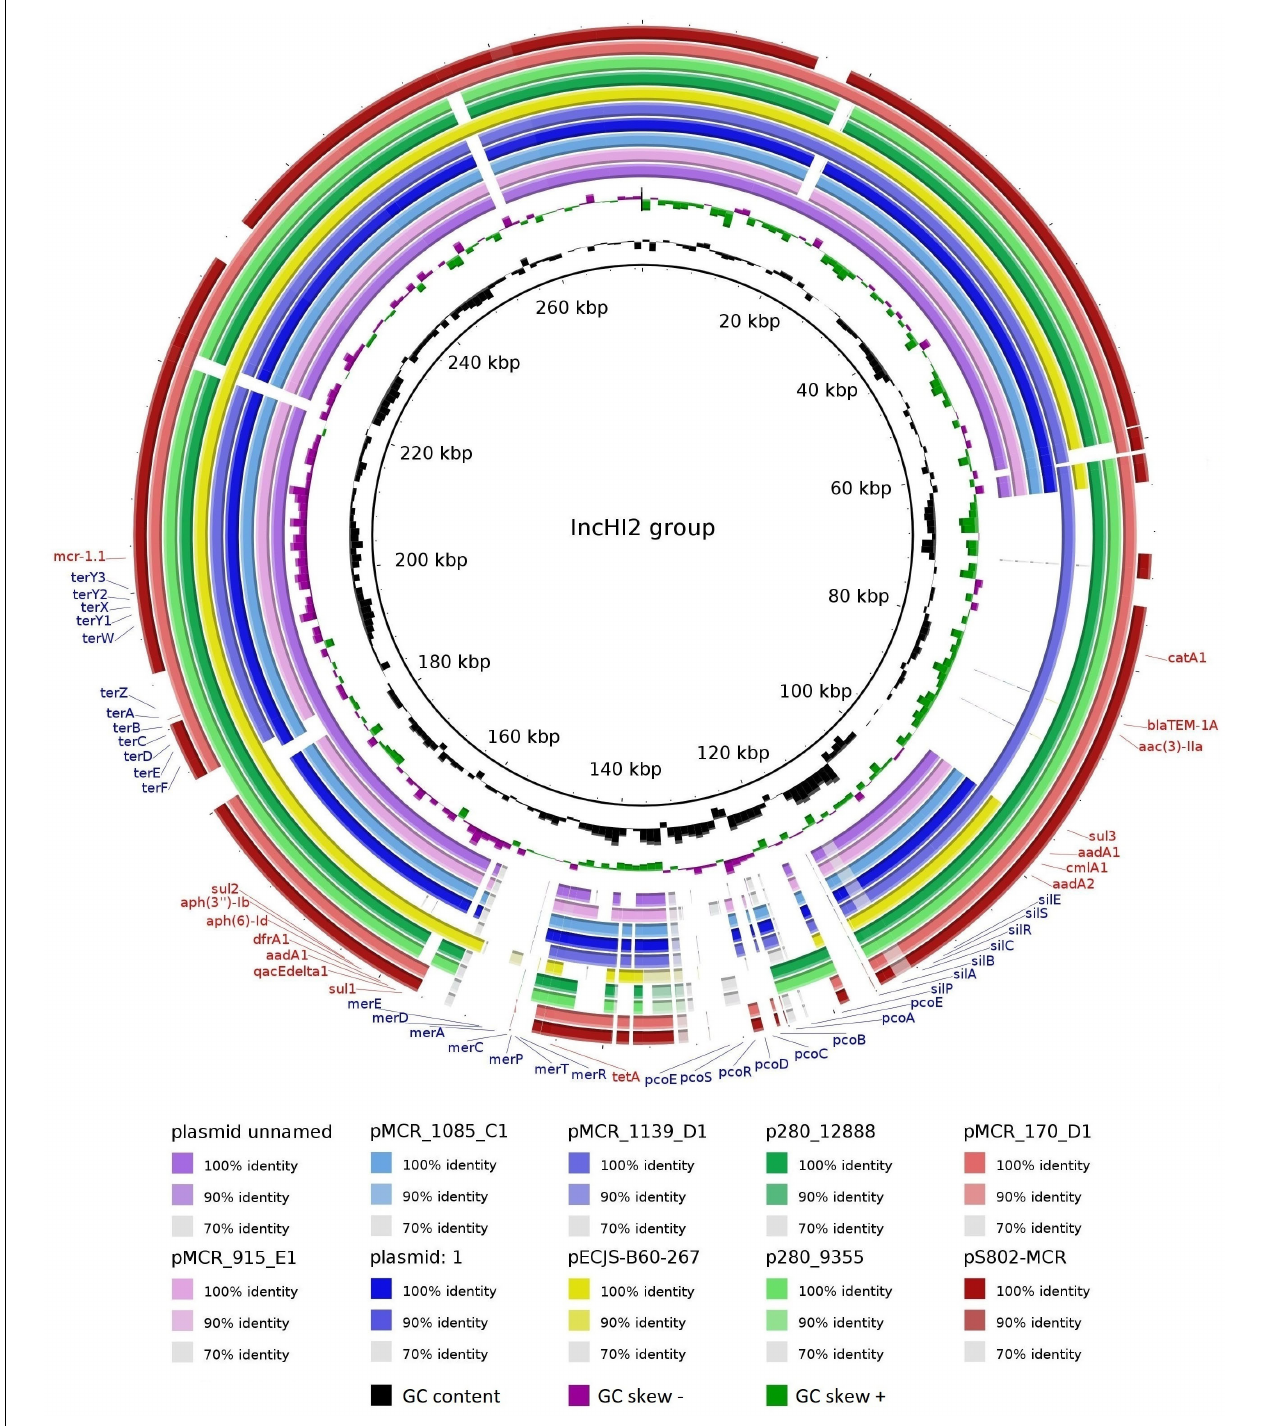
FIGURE 4 | Comparison between IncHI2 plasmids. Plasmids of E. coli strains: plasmid unnamed (GenBank: CP015833.1) from a human in the United Kingdom; plasmid: 1 (GenBank: LR882919.1) from a human in the Netherlands; pECJS-B60-267 (GenBank: KX254341.1) from a pig in China; pS802-MCR (GenBank: MW495059.1) from soil in Brazil; pMCR_915_E1 (GenBank: MT929285.1), pMCR_1085_C1 (GenBank: MT929286.1), pMCR_1139_D1 (GenBank: MT929287.1), and pMCR_170_D1 (GenBank: MT929288.1) from turkey meat in the Czech Republic. Plasmids of Salmonella Schwarzengrund strains: p280_12888 (GenBank: CP045449.1) and p280_9355 (GenBank: CP045446.1) from poultry in Brazil. Matches with less than 70% identity and no matches appear as blank spaces. Resistance genes to antimicrobials/biocides and metals are indicated in red and blue,